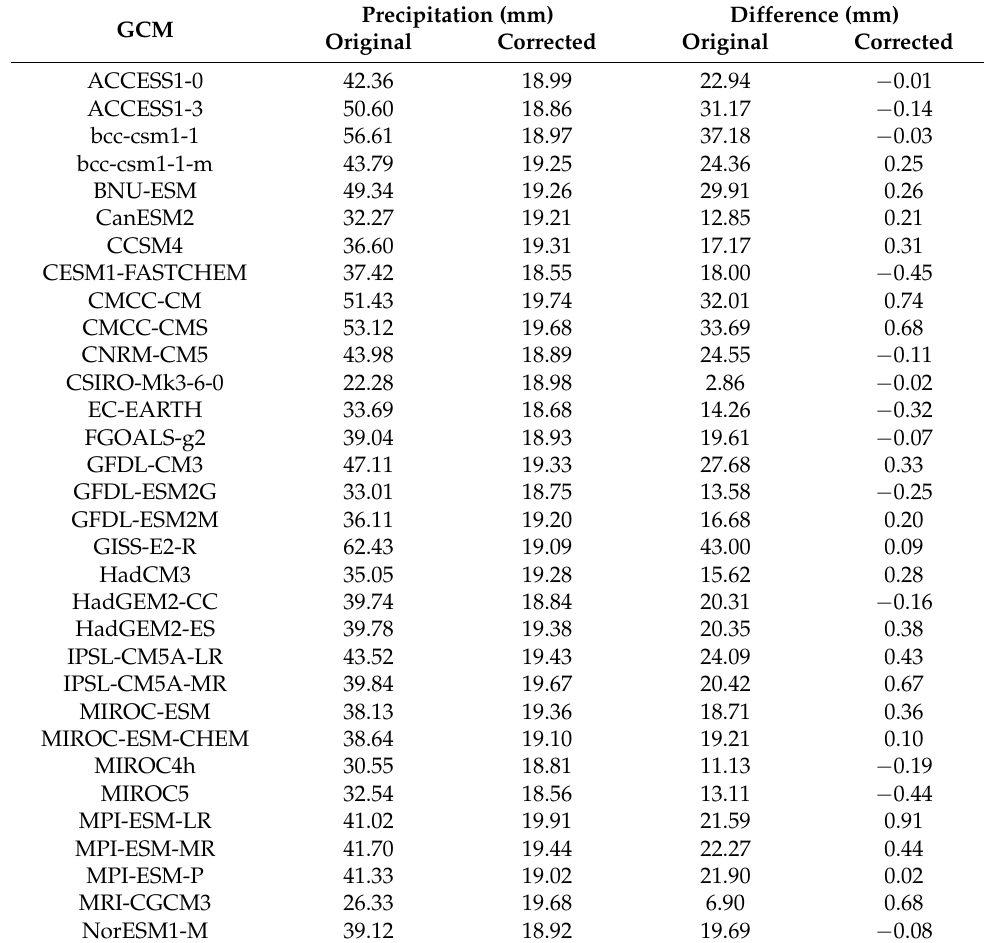
Table 6. The values of precipitation and its difference before and after modification in winter.